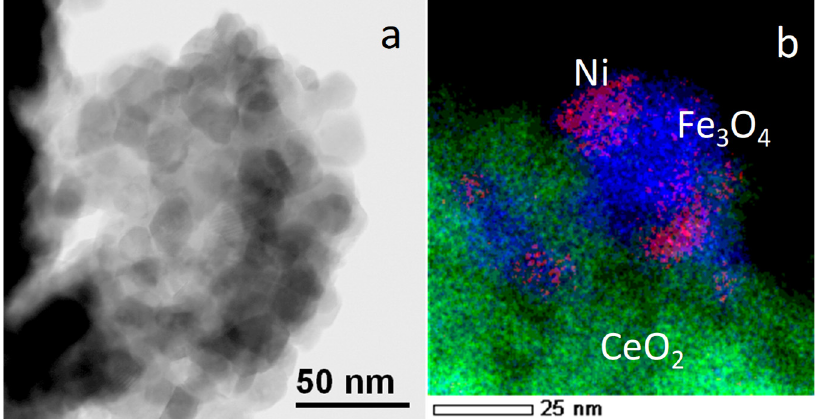
Figure 3. Transmission electron microscopy micrograph of 5%Ni/Fe 2 O 3- CeO 2 ( a ) and ( b ) higher magnification to show the energy-dispersive X-ray spectroscopy (EDX) element mappings of Fe (blue), Ce (green) and Ni (red), close to each other [48].